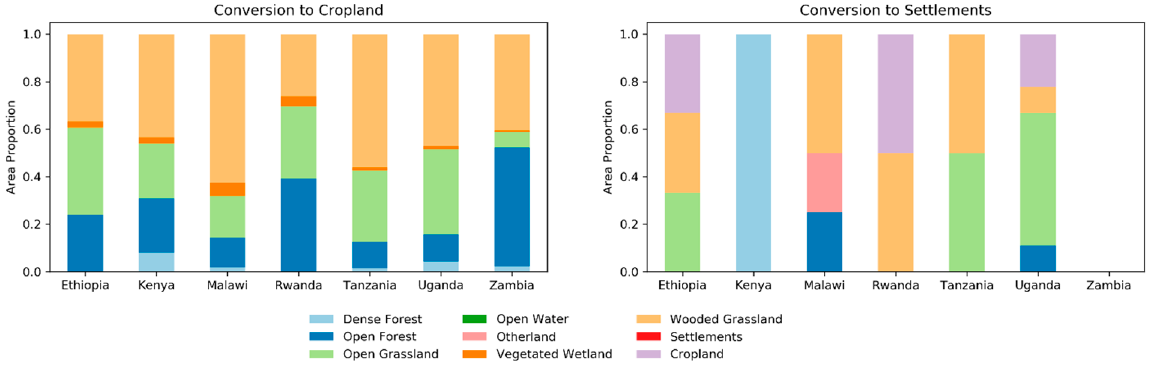
Figure 7. Previous cover type of land converted to Cropland ( left ) and Settlements, as a proportion of observed conversions per country.